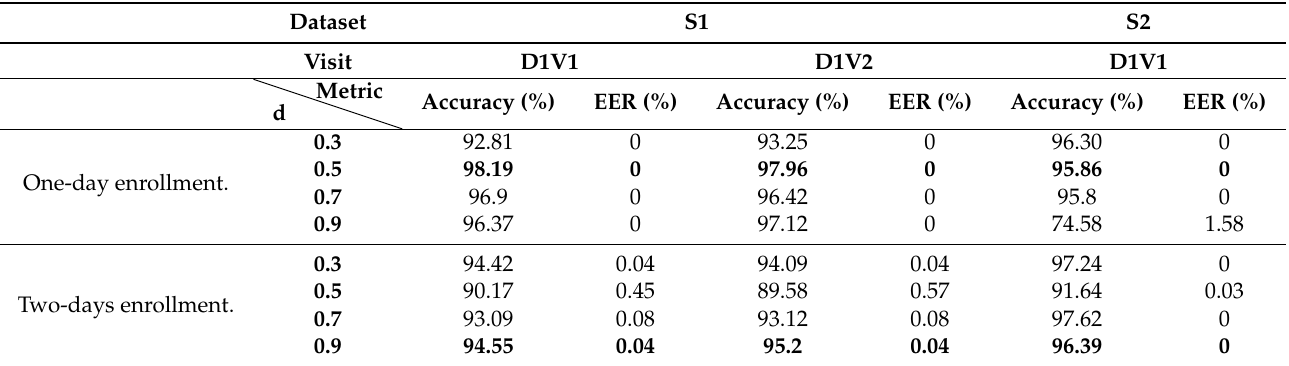
Table 4. Identification and verification results for same day in S1 and S2 for scenario R. The best considered options for one-day and two-days enrollment are in bold font.